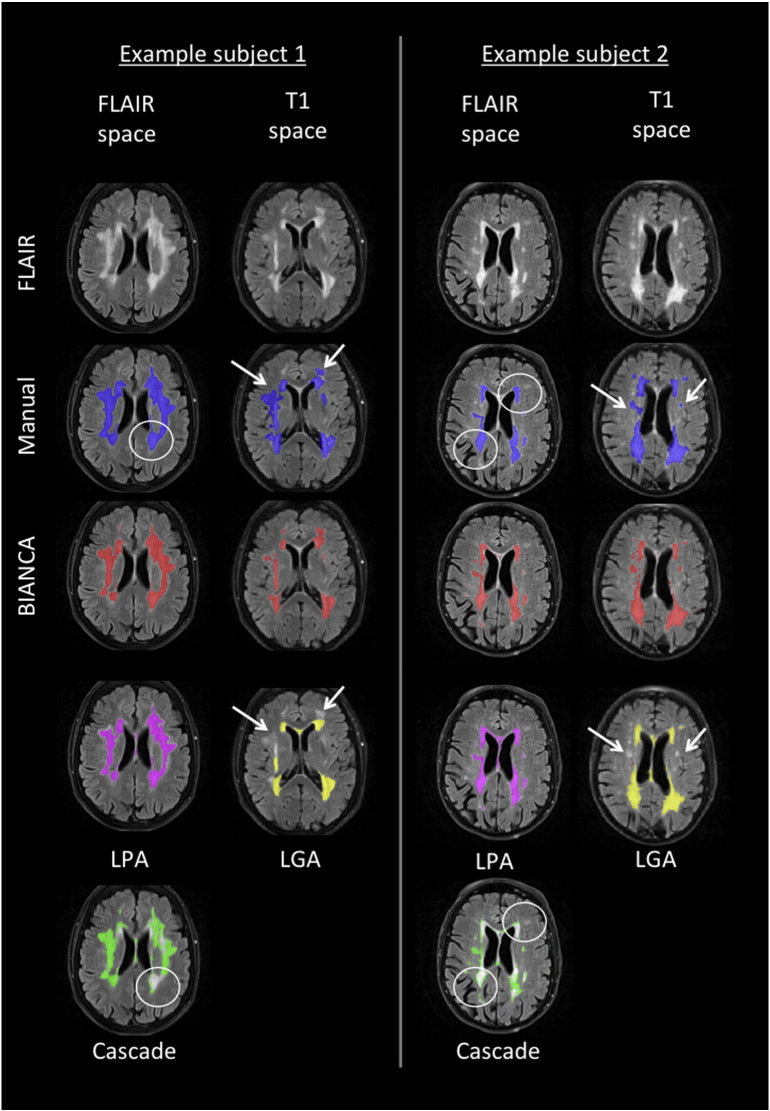
Example WMH segmentation with different tools. FLAIR images from two subjects are shown, together with the manual mask and the output from the different segmentation tools either in FLAIR space or T1w space, according to the reference space used for WMH segmentation by the algorithm. CASCADE (threshold = 0.8) and LPA gave the best performance on subject number one, while subject number 2 was the one giving the best LGA (kappa = 0.2) performance. White arrows and circles highlight the main segmentation errors by CASCADE and LGA, while BIANCA and LPA show good performance in both examples.